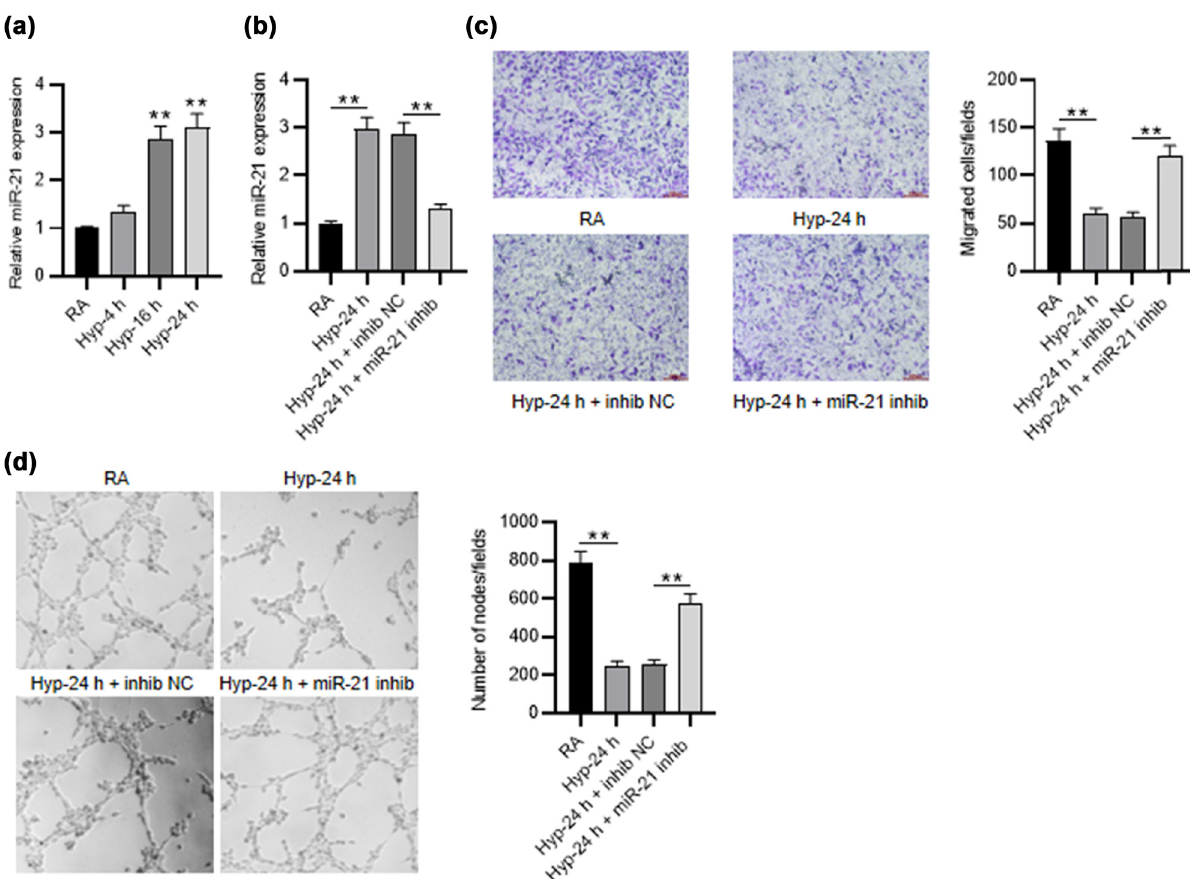
Figure 1: Inhibition of miR - 21 improves the angiogenic activity of PMVECs. ( a ) RT - qPCR was used to measure miR - 21 expression in PMVECs treated with RA or hyperoxia ( 4, 16, and 24 h ) . ( b ) The knockdown e ffi ciency of miR - 21 inhibitor in PMVECs treated with 24 h of hyperoxia was detected by RT - qPCR. ( c ) Transwell assay was applied for measuring the migration of hyperoxia - induced PMVECs when miR - 21 was silenced. ( d ) Tube formation assay was performed to estimate the angiogenic activity of hyperoxia - induced PMVECs after miR - 21 inhibition. Quanti fi ed values are mean values ± standard deviation of at least three independent experiments. ** p <